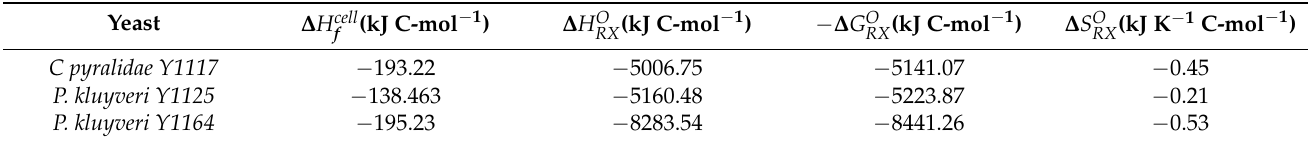
Table 8. Thermodynamic parameters during biochemical conversion of substrate and secondary metabolite production (biopreservatives) by C. pyralidae Y1117, P. kluyveri Y1125, and P. kluyveri Y1164 using grape pomace extract as fermentation medium at 298.15 K and 1